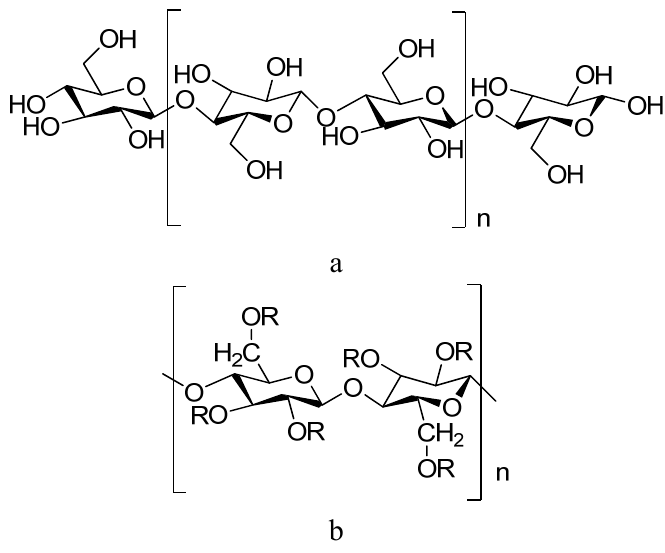
Figure 1. Chemical structure of a) powdered cellulose (n ≈ 500) or microcrystalline cellulose (n ≈ 220) and b)